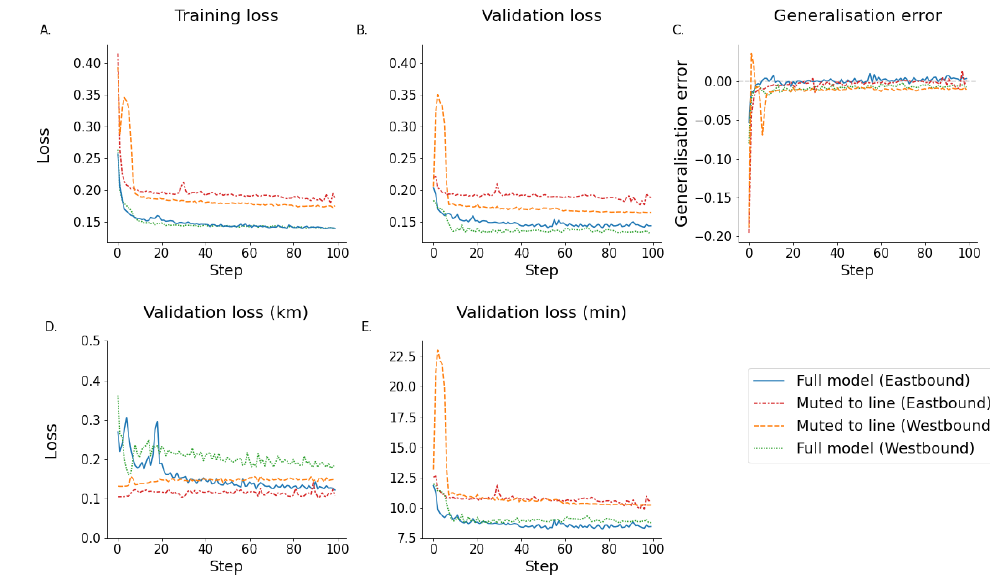
Figure 10. These figures show the model muted to vehicles of the same line regardless of their location in relation to the target vehicle. This is compared to network-based model clearly showing that the performance is reduced if the model does only have access to indiscriminate information of its own line. ( A ) shows the training loss. ( B ) shows the validation loss. ( C ) shows the generalisation error calculated by subtracting the training error from the testing error. ( D ) shows the estimated validation error in km. ( E ) shows the estimated validation loss in minutes. (Note that subfigure ( D ) has a truncated y axis for illustration